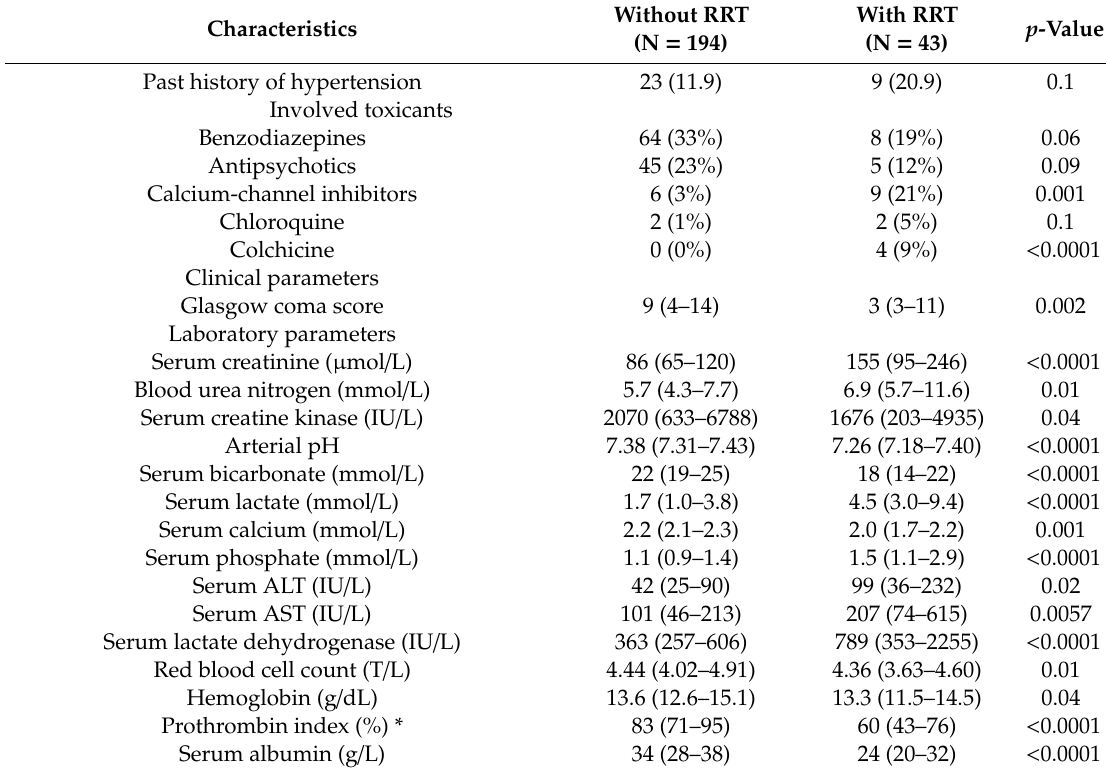
Table 6. Clinical and laboratory parameters in the poisoned patients who developed rhabdomyolysis according to renal replacement therapy (RTT) requirement.